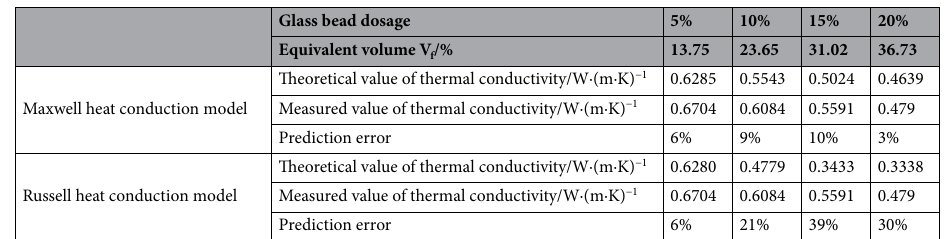
Table 5. Evaluation of Maxwell heat-conduction model for composites.